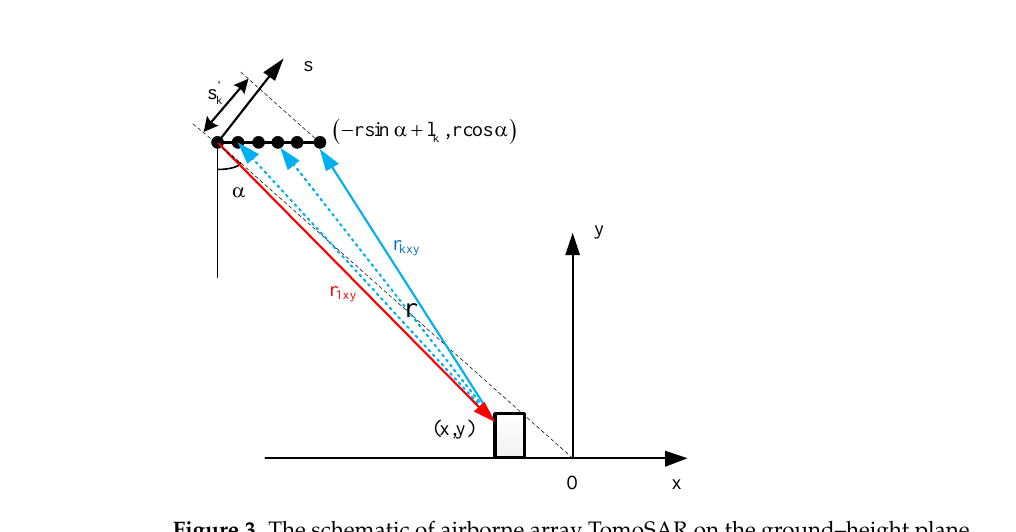
Figure 3. The schematic of airborne array TomoSAR on the ground–height